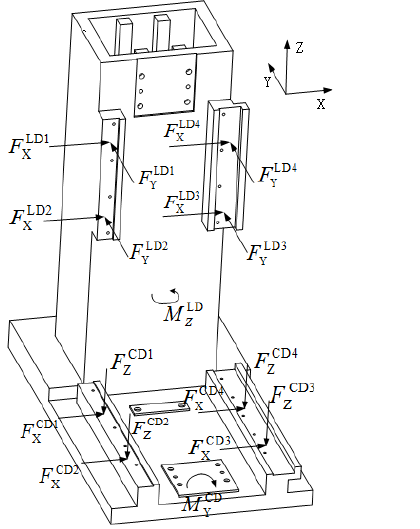
Figure 9. Equivalent load distribution on the connecting surface of the bearing housing. ( a ) Integral structure ( b ) Separate structure.